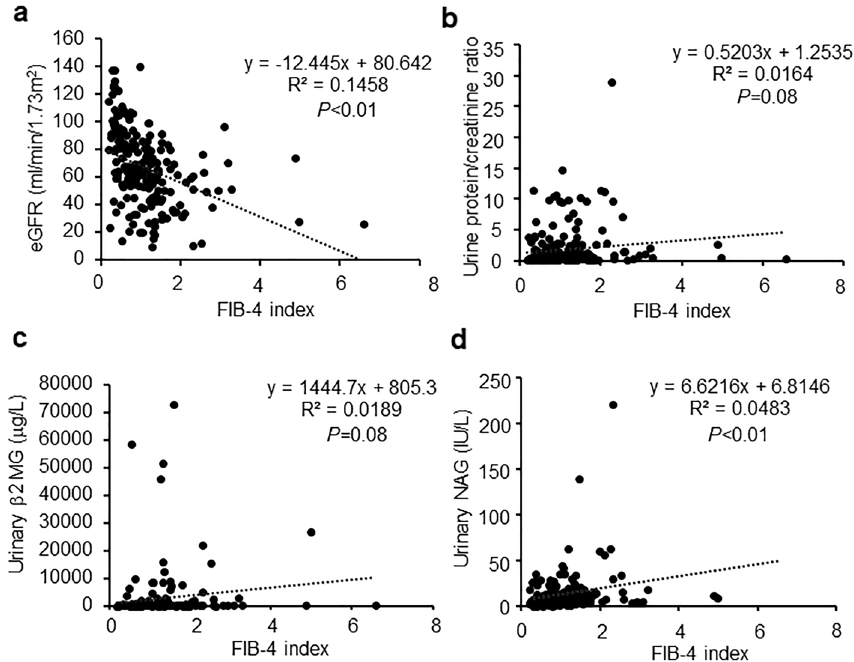
Figure 1. Associations of the FIB-4 index and renal function markers. ( a ) Correlation between the FIB-4 index and estimated glomerular filtration rate. ( b ) Correlation between the FIB-4 index and urine protein-creatinine ratio. ( c ) Correlation between the FIB-4 index and urinary b2 microglobulin. ( d ) Correlation between the FIB-4 index and urinary N -acetyl-b-d-glucosaminidase.